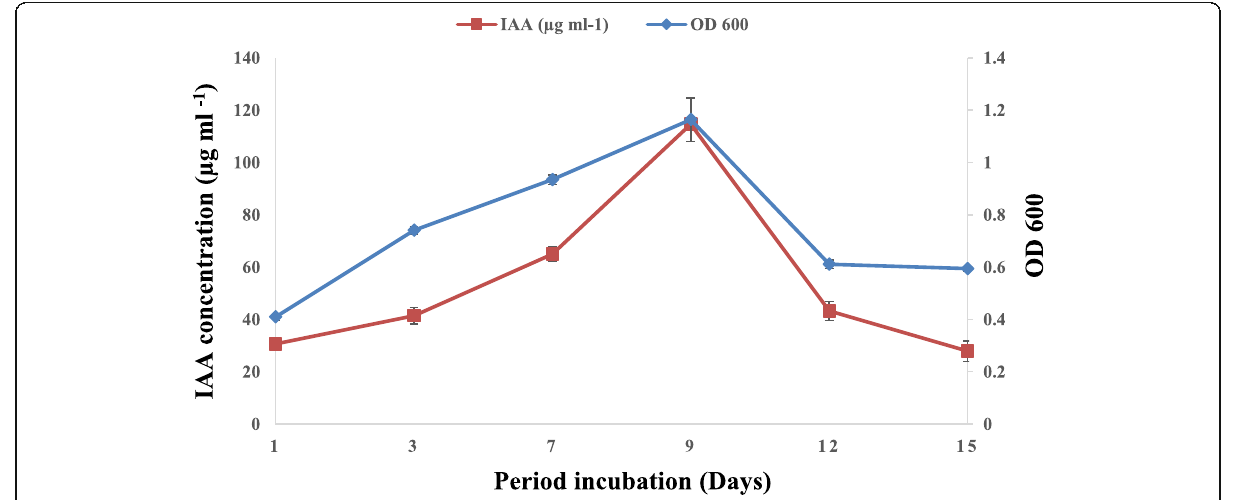
Fig. 2 Effect of incubation period on Rhizobium sp . growth and IAA